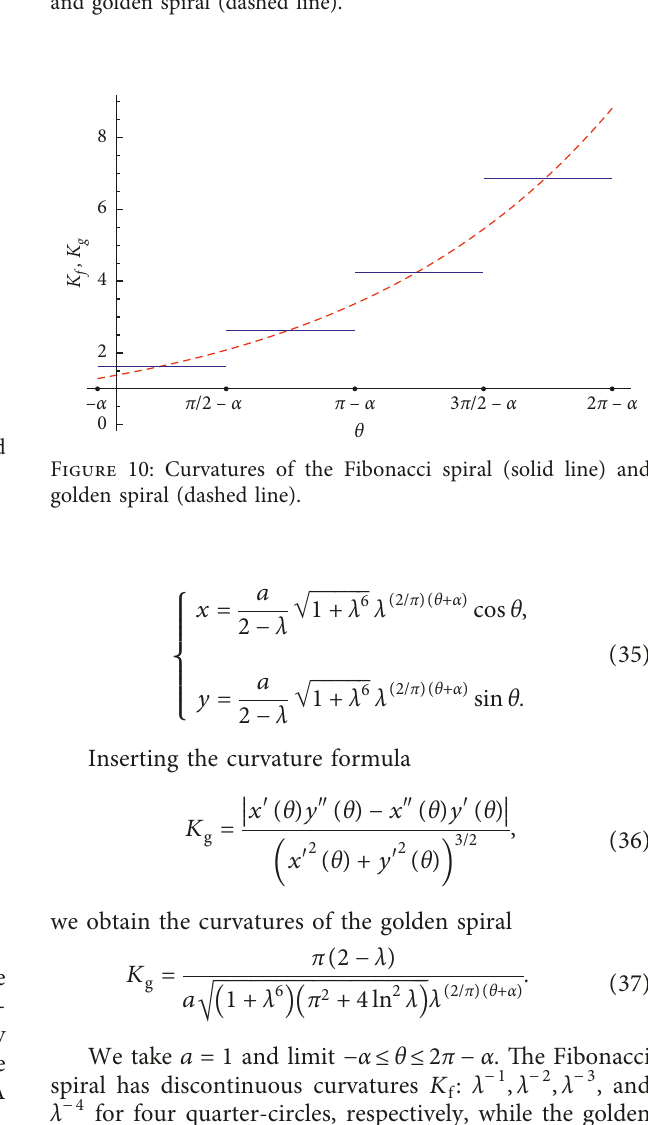
Figure 6: The Fibonacci spiral (solid line) and golden spiral (dashed